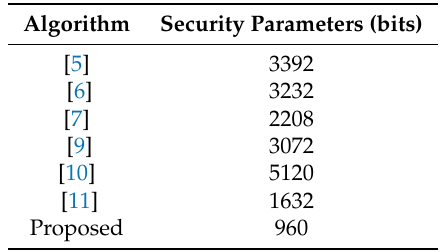
Table 6. Memory occupied by the security